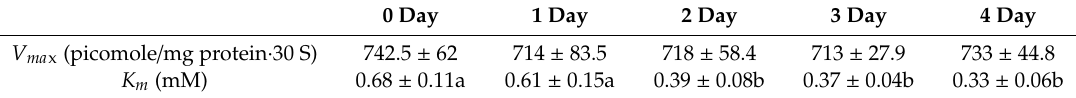
Table 1. Kinetic parameters of Na-K-ATPase transporters in IEC-18 cells.